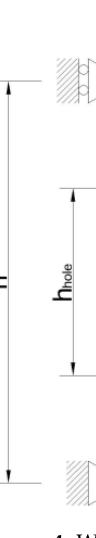
Figure 4. Web model used to determine k ϕ . To obtain the rotational stiffness k ϕ , a uniformly distributed bending moment M was applied to the upper side of the web along a half wavelength L crd , as shown in Figure 5, and the corresponding buckling deflection of the web when it deforms can be described by